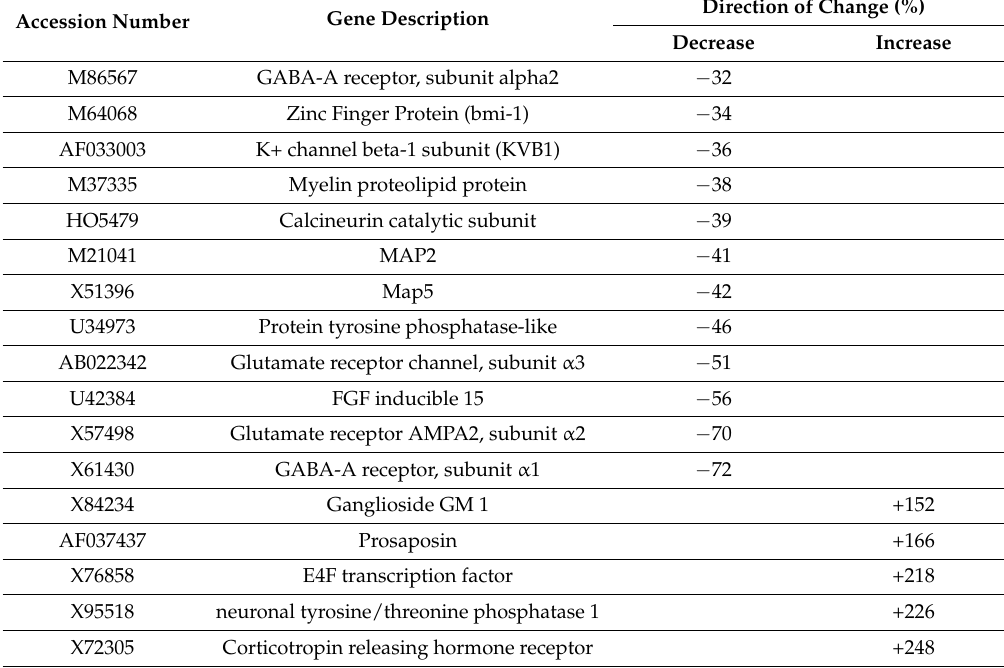
Table A2. Hippocampal DNA micro-array. Complementary DNA was reversed transcribed from the mRNA extracted from WT and CRMP3 − / − hippocampi (3 months old; 8 animals/genotype), and then hybridized to microarrays. Following hybridization, the arrays were washed and scanned following standard Affymetrix protocols (Affymetrix GeneChip Genome arrays; Affymetrix, Santa Cruz, CA, USA). Genes with change in mRNA expression of more than 30% are